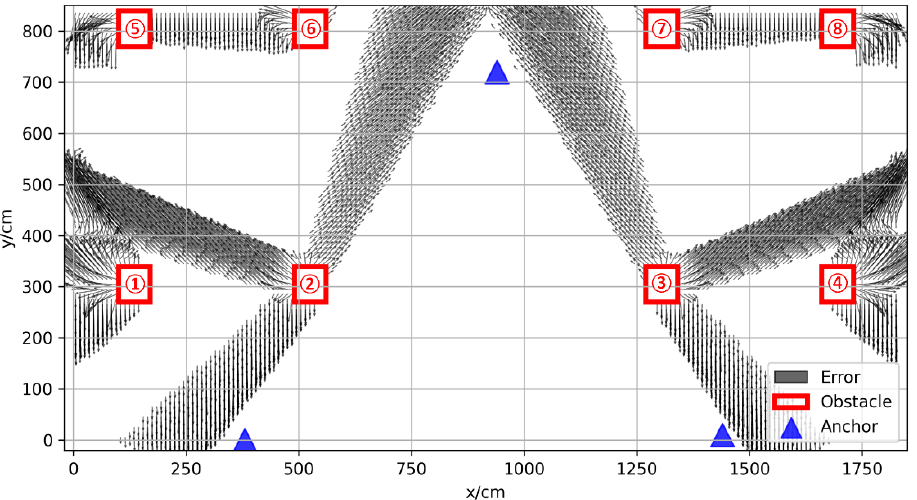
Figure 4. Vector positioning error map of experimental environment.